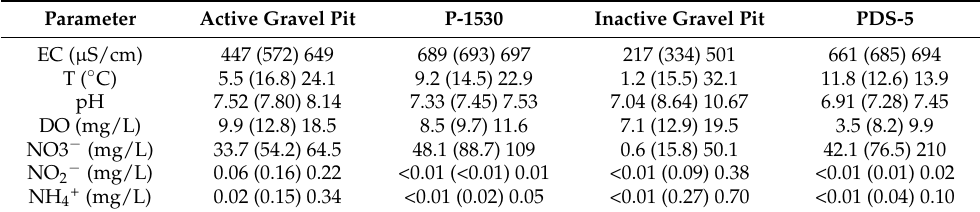
Table 1. In situ parameters and nitrogen species recorded in investigated gravel pits and in ground- water (observation wells). Data are shown as minimum and maximum values with mean values in parentheses.